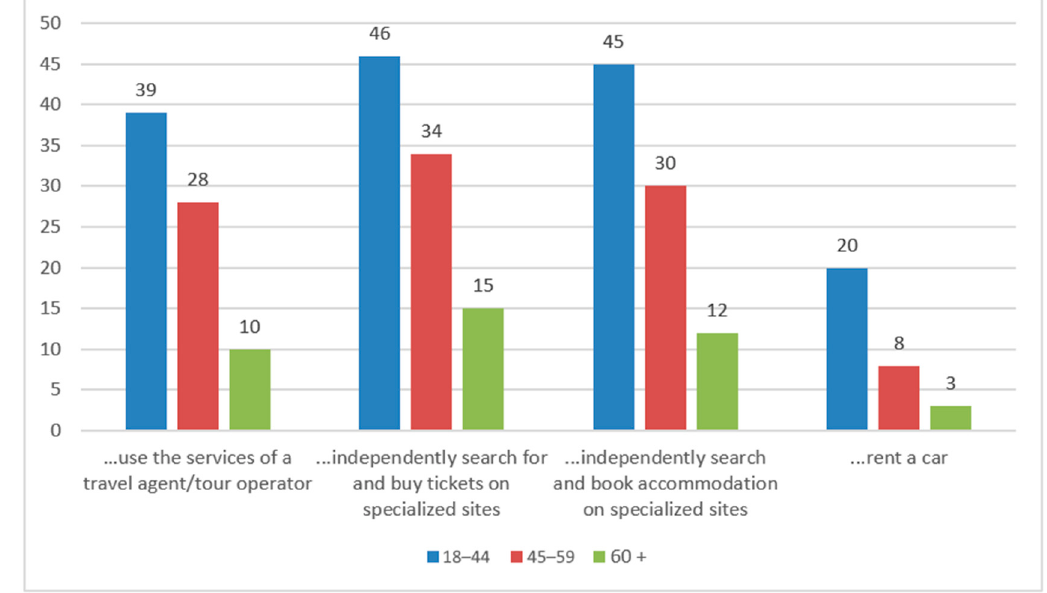
Figure 2. Respondent answers to the question, “If we talk about your upcoming vacation, how likely is it that you...”, by age (NAFI 2019).